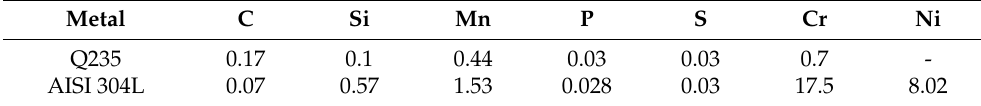
Table 2. Chemical compositions of the related base metals